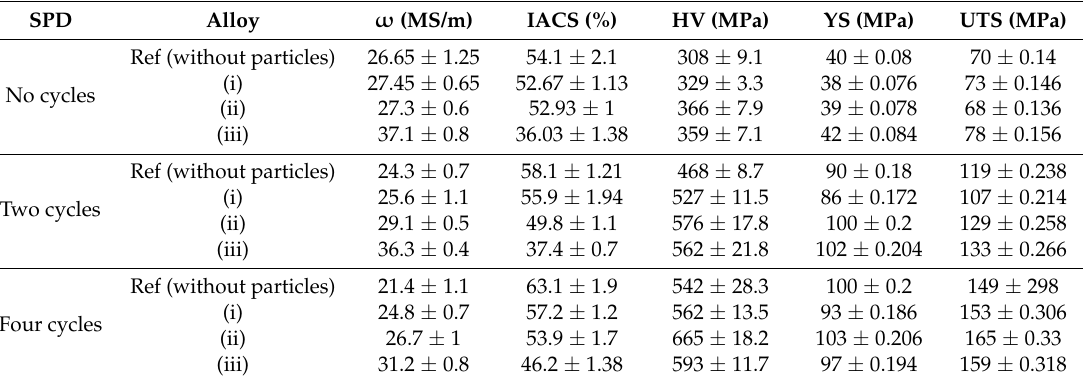
Table 2. Properties of the alloys obtained.